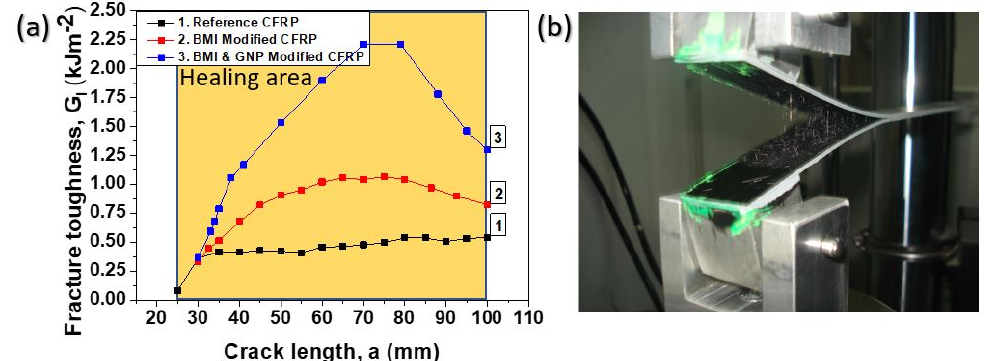
Figure 4. ( a ) Typical crack opening resistance curves (R-curves) under mode I loading conditions for the reference and modified CFRPs with pure BMI and BMI and GNPs. ( b ) Snapshot of a mode I test specimen (DCB) during testing.